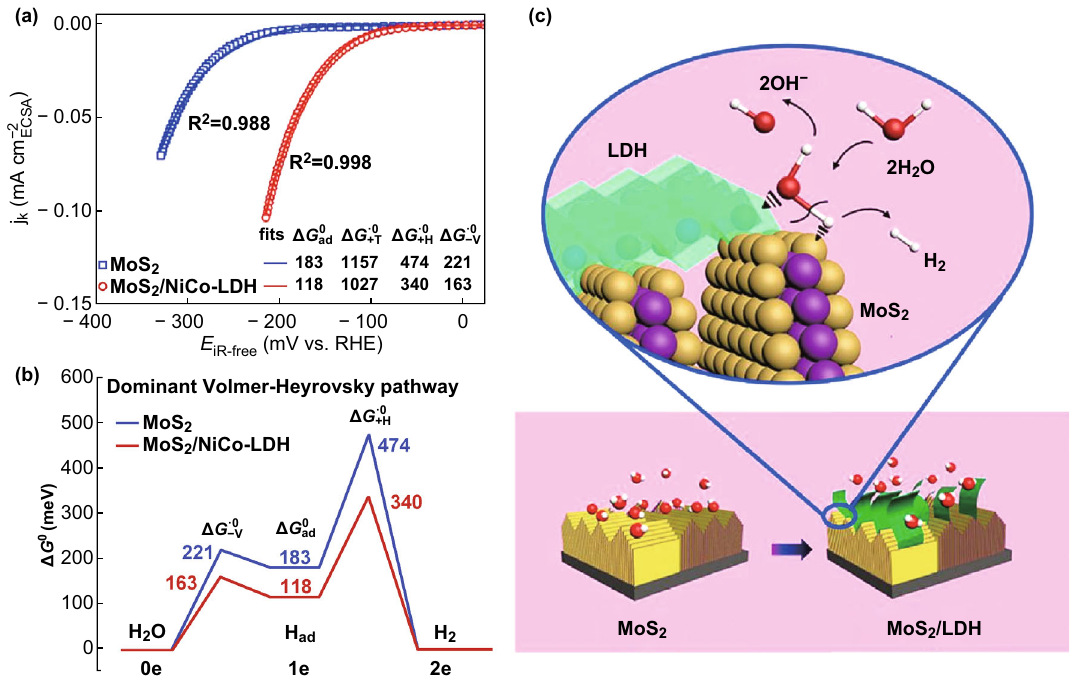
Fig. 4 a ECSA-normalized polarization curves (symbols) of bare MoS 2 and MoS 2 /NiCo-LDH composite catalysts in 1 M KOH solution with the best fits (lines) using the dual-pathway kinetic model. The fitted standard activation free energies are presented in units of meV. b Free energy diagram of the dominant Volmer–Heyrovsky pathway for HER in alkaline electrolyte for bare MoS 2 (blue) and MoS 2 /NiCo-LDH composite (red) catalysts. c Schematic illustration of the HER at MoS 2 /LDH interface in alkaline environment. Synergistic chemisorption of H (on MoS 2 ) and OH (on LDH) for enhancing the water dissociation step. Reproduced with permission of the authors of Ref. [44]. Copyright 2017, Cell Press. (Color figure